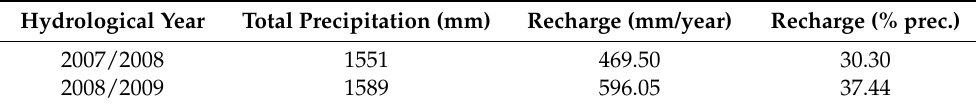
Table 6. Total annual effective recharge using baseflow